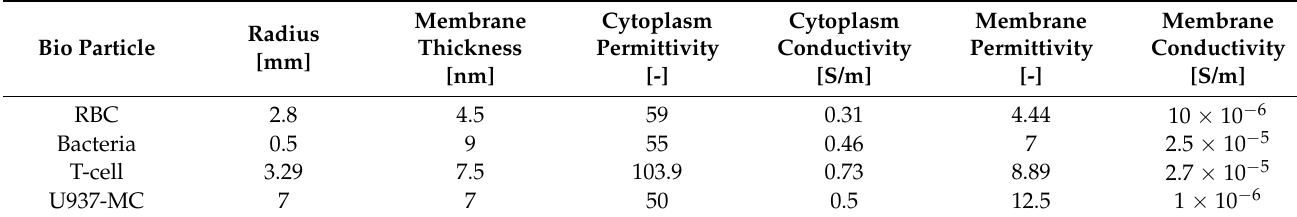
Table 4. The bioparticle properties [49].